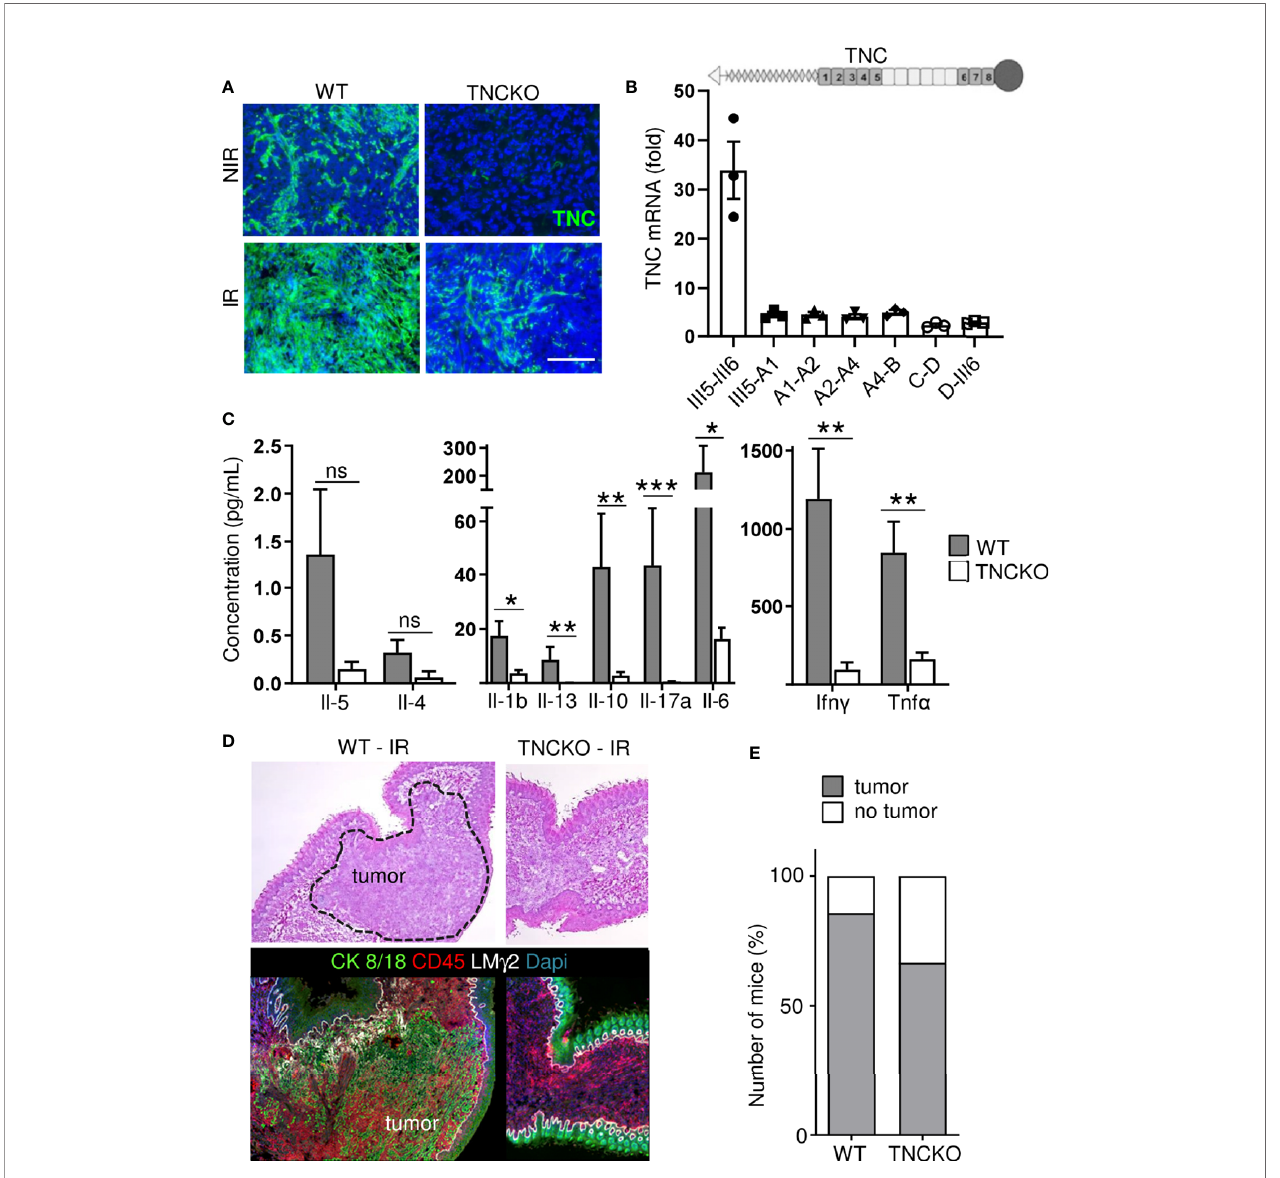
FIGURE 6 | Impact of TNC on T cell stimulation and on OSCC13 tumor abundance upon irradiation. (A) TNC immunostaining of non-irradiated (NIR) and irradiated (IR) tumors from WT and TNCKO mice 2 weeks upon irradiation with 2 Gy. Scale bar 100 µm. WT, N = 6, TNCKO, N = 9. (B) Gene expression analysis (qRTPCR) of different TNC FNIII domains (exon junctions) in OSCC13 cells 24 h upon 2 Gy irradiation (normalized to GAPDH). N = three experiments. The domain organization of TNC is schematically depicted on top with heptad oligomerization domain (triangle), FNIII domains (dark, constant, light, alternatively spliced) and fi brinogen globe (circle). (C) Expression of cytokines in T cells present in OSCC13 tumors from WT and TNCKO mice (2 weeks upon engraftment), 24 h after stimulation with CD3/ CD28 beads, with a cytokine cytometry bead array (CBA) assay. Mean ± SEM, Mann – Whitney test, *p < 0.05, **p < 0.01, ***p < 0.05. (D) Representative H&E and immunostaining images for CK8/18 and CD45 (N = 5) of a non-irradiated and irradiated tongue from a OSCC13 tumor bearing mouse (WT or TNCKO). (E) Detection of tumors (by CK8/18 signal) in irradiated WT (N = 6/7) and TNCKO mice (N = 6/9); ns, not signi fi cant. Note that whereas all engrafted mice developed tumors in both genotypes, upon irradiation there was a partial